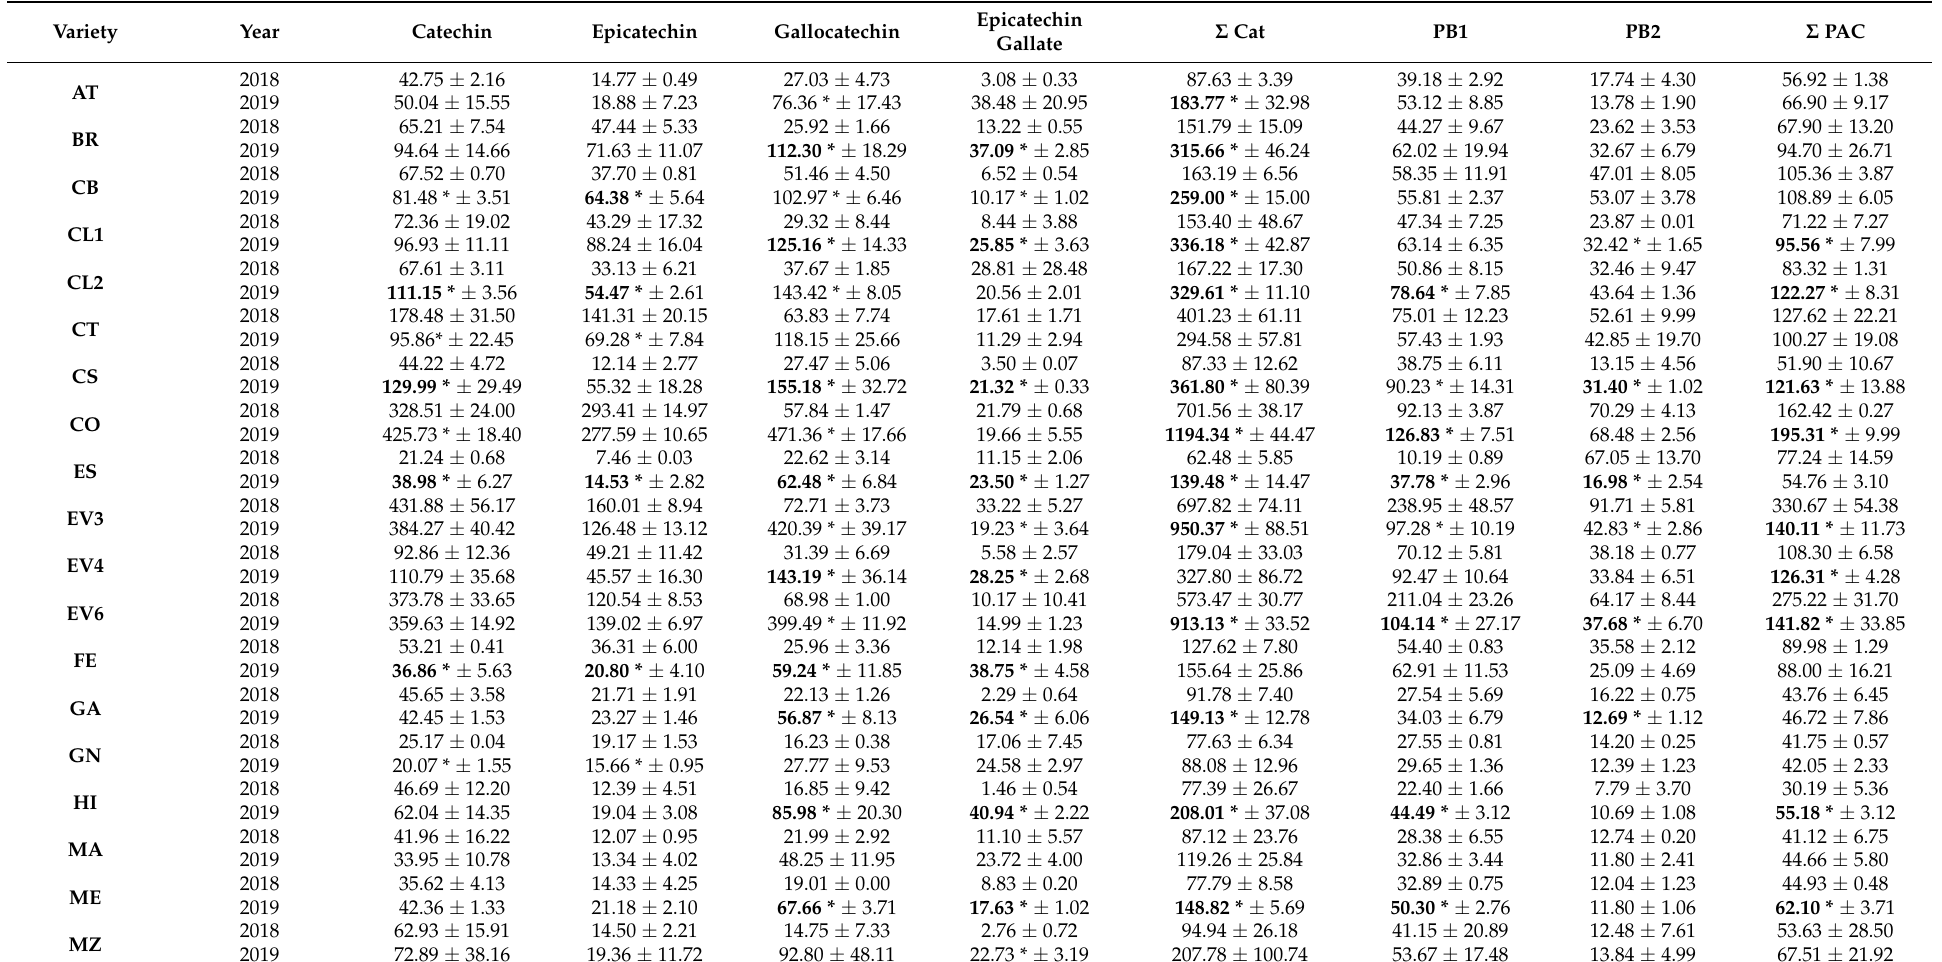
Table 4. Concentration of non-anthocyanin phenolic compounds: flavanols (FLAVA) from the EVEGA germplasm bank in 2018 and 2019 vintages. (Values are expressed as mg kg − 1